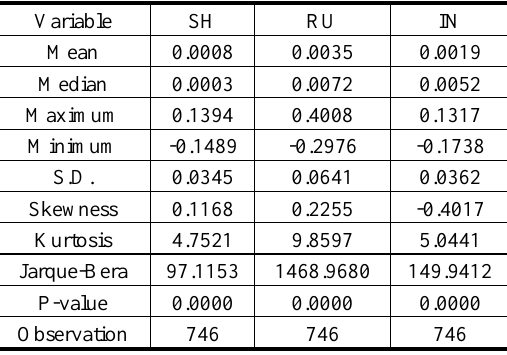
Table 1 A Summary Statistics of the Return Series